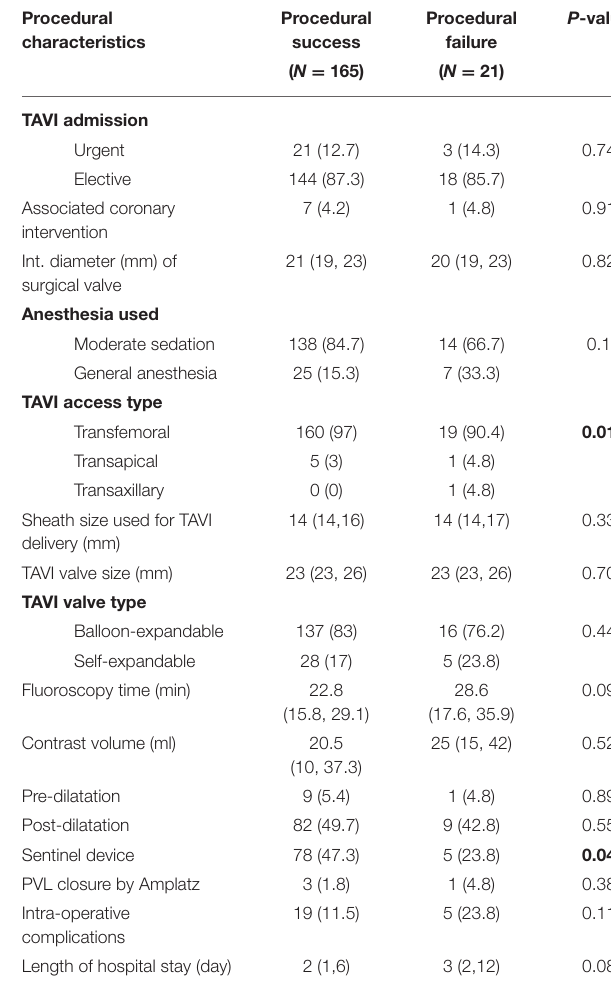
TABLE 3 | Procedural characteristics of patients in the procedural success and failure